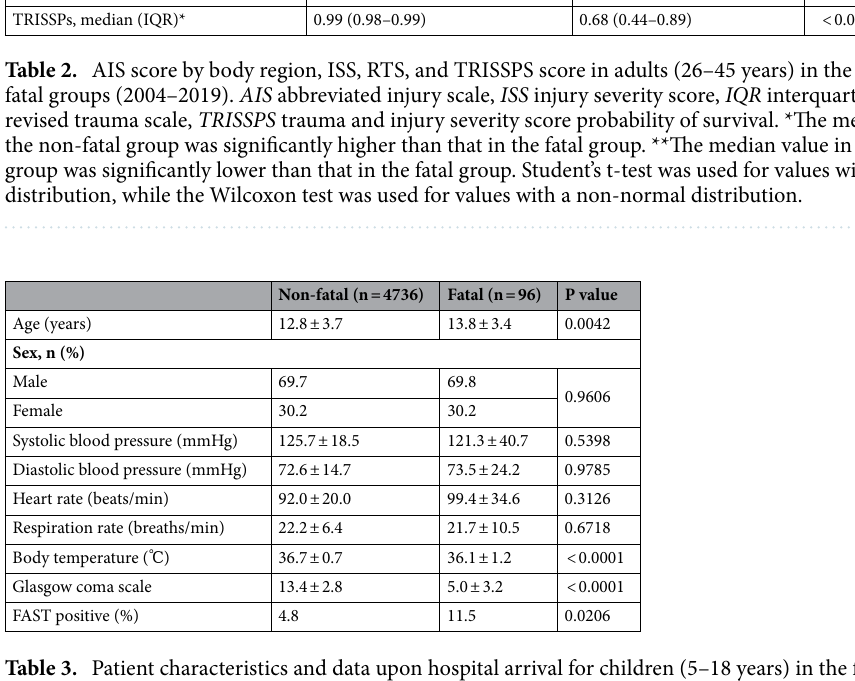
Table 3. Patient characteristics and data upon hospital arrival for children (5–18 years) in the fatal and non- fatal groups (2004–2019). FAST focused assessment with sonography for trauma. Student’s t-test was used for values with a normal distribution, while the Wilcoxon test was used for values with a non-normal distribution.